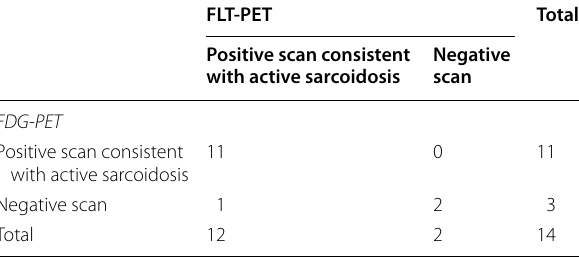
Table 3 Comparison of FLT- and FDG-PET for the diagnosis of active sarcoidosis [ κ 0.76 (95% CI 0.32–1.0)] =